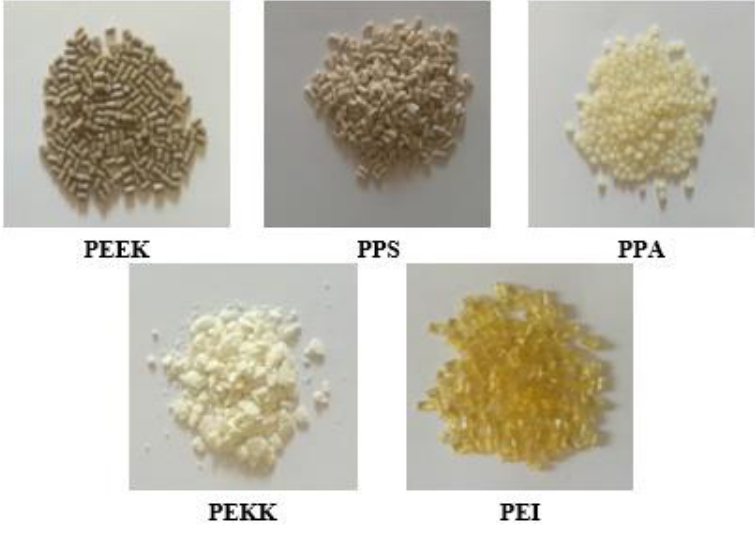
Figure 3. Polymers tested in the project.